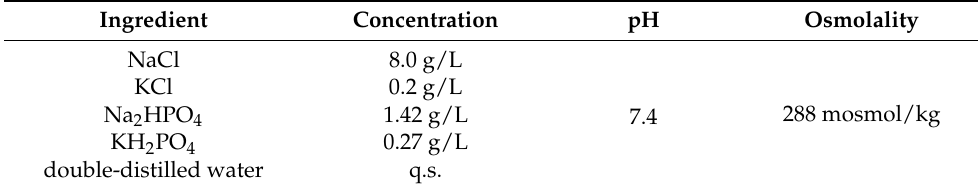
Table 3. Composition of phosphate buffered saline